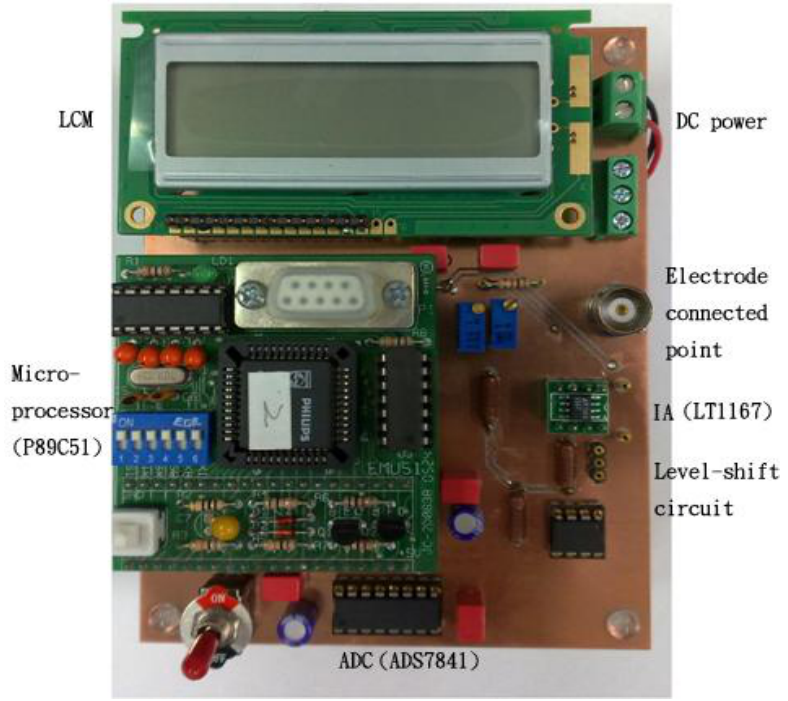
Figure 8. The designed electrochemical sensing